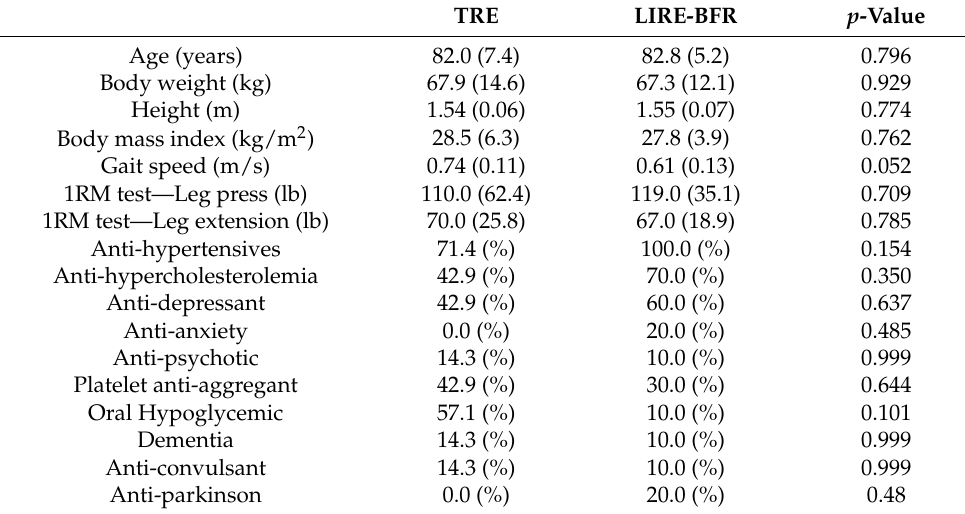
Table 1. Characteristics of participants and medications.